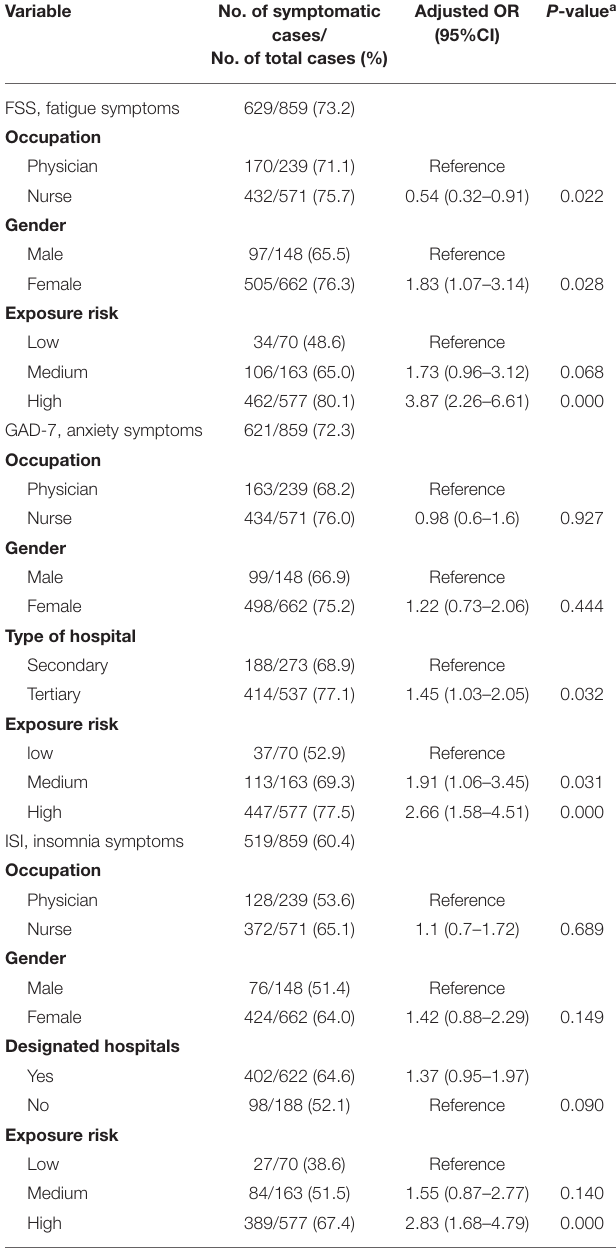
TABLE 4 | Risk factors for mental health symptoms identified by binary logistic regression.